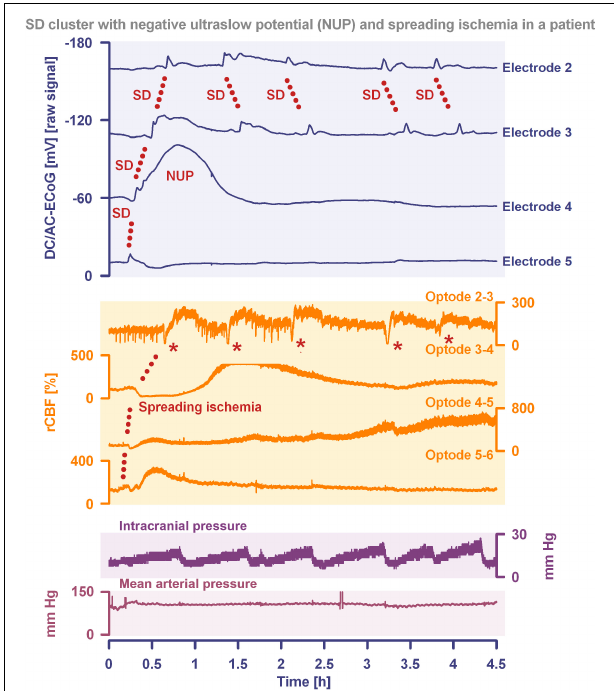
FIGURE 2 | Spreading depolarization inducing a spreading ischemia and a NUP. In total, this 44-year old, previously healthy woman had 174 spreading depolarizations and died due to progressive brain infarctions on day 13 (Luckl et al., 2018). The spreading depolarizations shown in the figure were recorded on day 9 after the initial hemorrhage. Traces 1–4 from top to bottom give the DC/AC-ECoG recordings (band-pass: 0–45 Hz). Spreading depolarization is observed as a negative DC shift propagating across the cortex from electrode 5 to electrode 2. At electrode 4, the spreading depolarization initiates a NUP, the electrocorticographic correlate of infarction (Luckl et al., 2018). At electrodes 2 and 3, several shorter-lasting spreading depolarizations accompany this. Traces 5–8 give regional cerebral blood flow (rCBF) recorded with four optodes between the electrodes. At the optode between electrodes 3 and 4, the spreading depolarization induced the characteristic long-lasting drop in rCBF typical of spreading ischemia. The duration of the NUP at electrode 4 correlates well with the duration of the spreading ischemia because the decrease in perfusion and energy supply limit Na + /K + -ATPase activity and prolong the neuronal depolarization (Dreier et al., 1998; Dreier, 2011; Major et al., 2017). In contrast, only short-lasting spreading depolarization-induced initial hypoperfusions followed by hyperemias are seen at optode 2–3 (compare red asterisks). Animal experiments suggested that, if sufficiently prolonged, spreading ischemia causes necrosis (Dreier et al., 2000). Accordingly, the patient developed a new scattered infarct at electrodes 4–6 between days 8 and 12. After the spreading ischemia shown in the figure, subsequent ones also involved (opto-) electrodes 4–6. Trace 9 gives the intracranial pressure recorded using an extraventricular drainage catheter and trace 10 mean arterial pressure recorded using a catheter in the radial artery. The marked fluctuations in intracranial pressure typically result from manual opening and closing of the drainage catheter. The time is given in hours